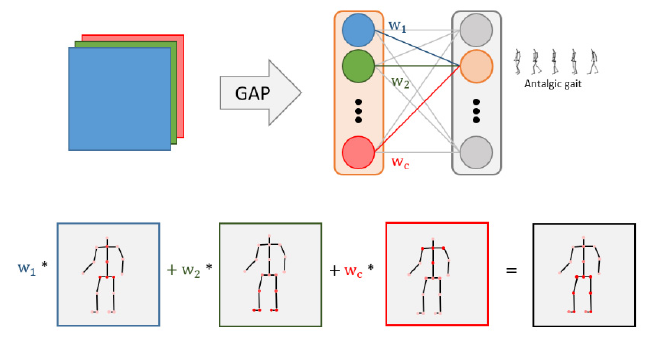
Figure 7 . Separable convolution for skeleton ‐ based action recogn ition . Figure 7. Separable convolution for skeleton-based action